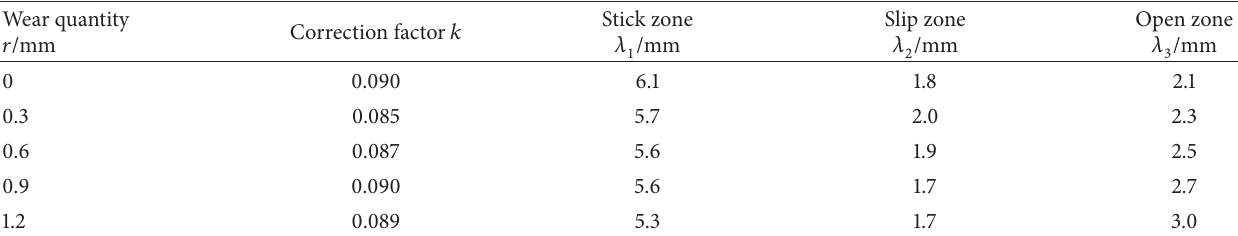
Table 5: Sizes of three zones under different wear